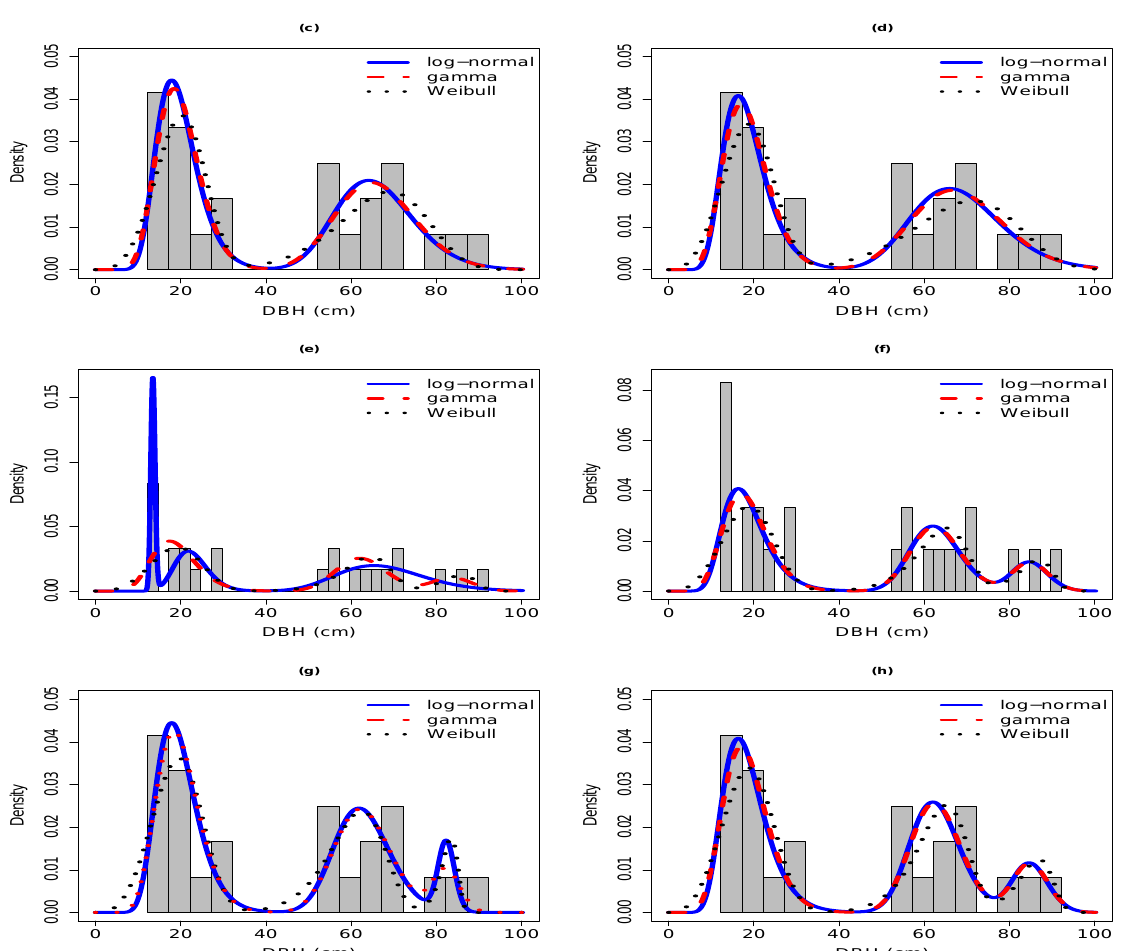
Figure A1. Histograms of DBH data in sample 1. ( a ): 2-component mixture models fitted to grouped data corresponding to classes of width 2.5 cm, ( b ): 2-component mixture models fitted to ungrouped data, ( c ): 2-component mixture models fitted to grouped data corresponding to classes of width 5 cm, ( d ): 2-component mixture models fitted to ungrouped data, ( e ): 3-component mixture models fitted to grouped data corresponding to classes of width 2.5 cm, ( f ): 3-component mixture models fitted to ungrouped data, ( g ): 3-component mixture models fitted to grouped data corresponding to classes of width 5 cm, ( h ): 3-component mixture models fitted to ungrouped data. Superimposed are estimated pdf of the mixture of Weibull (solid line), gamma (dashed line), and log-normal (dotted line) distributions.